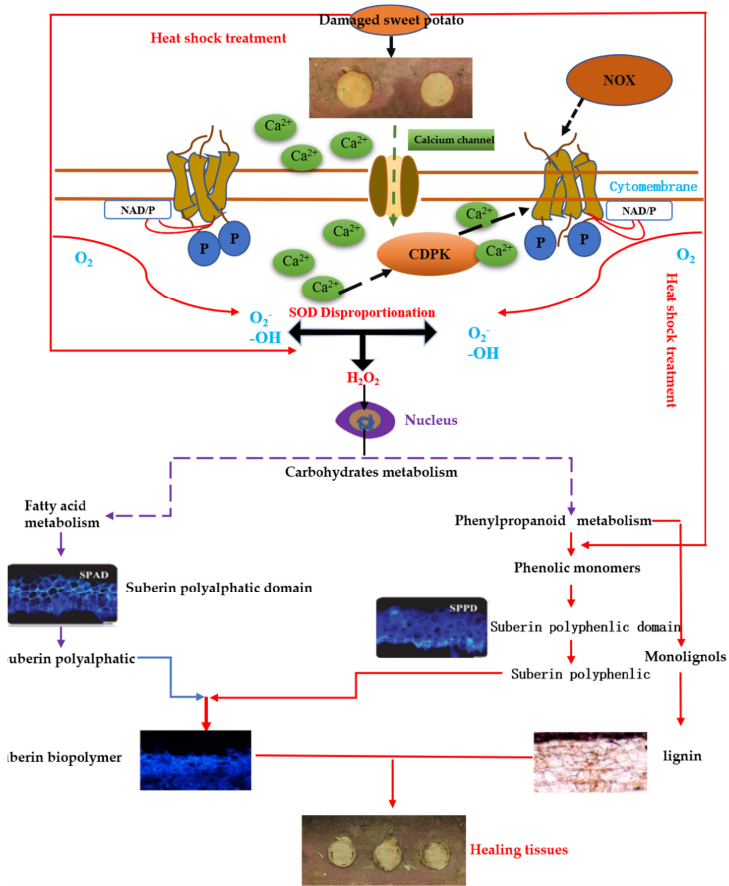
Figure 7. Pattern of metabolic pathways involved in callus of sweet potato tuber under heat shock treatment. CDPK: calcium-dependent protein kinase; NOX: NADPH oxidase; SOD: superoxide dis- mutase